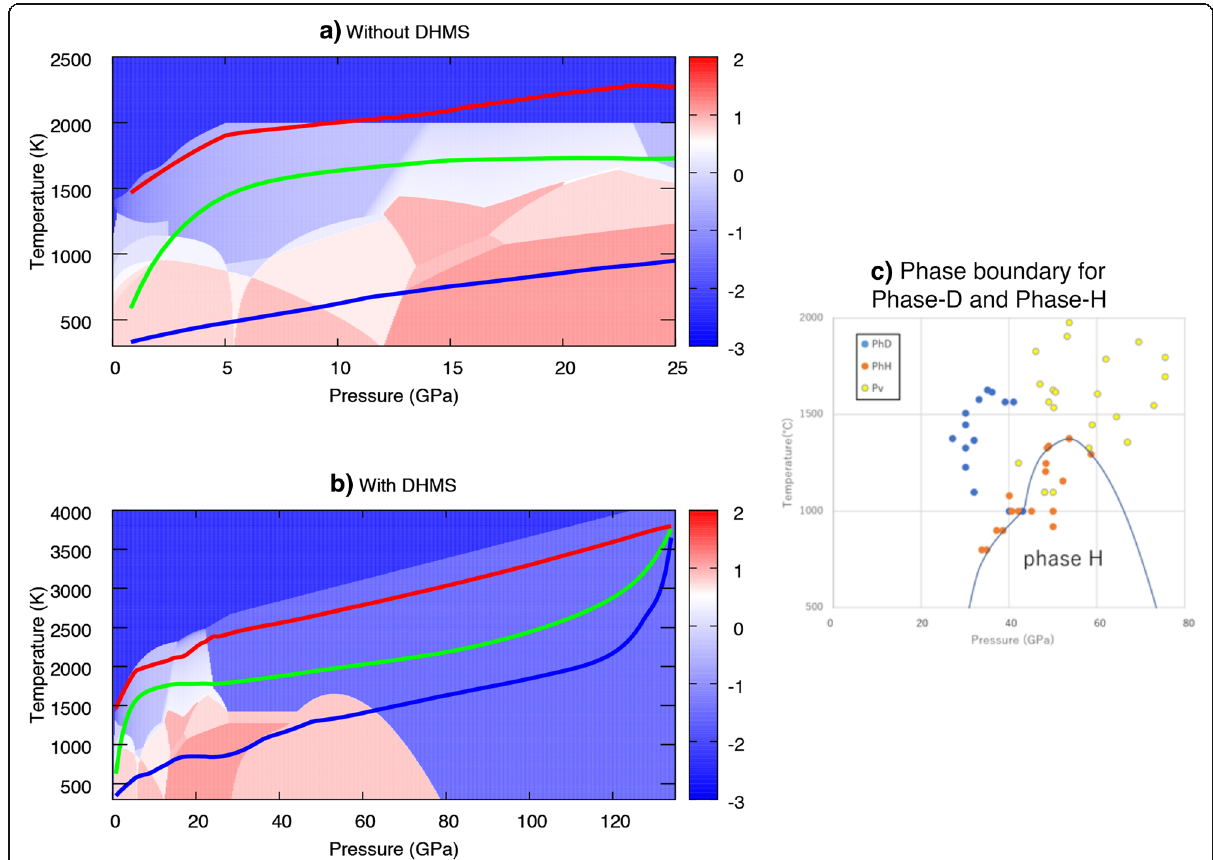
Fig. 1 a Water solubility maps of the mantle. Upper mantle only (Iwamori 2007). b The full range of mantle temperatures and pressures. Lines indicate cold (blue), average (green), and hot (red) mantle geotherms for cases of 12 ocean masses of total water without ( a ) or with ( b ) DHMS